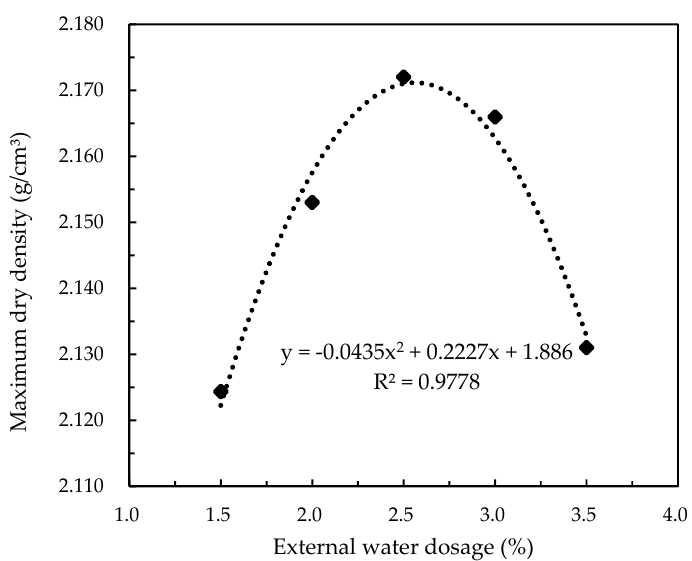
Figure 2. Influence of external water dosage on the maximum dry density of specimens.